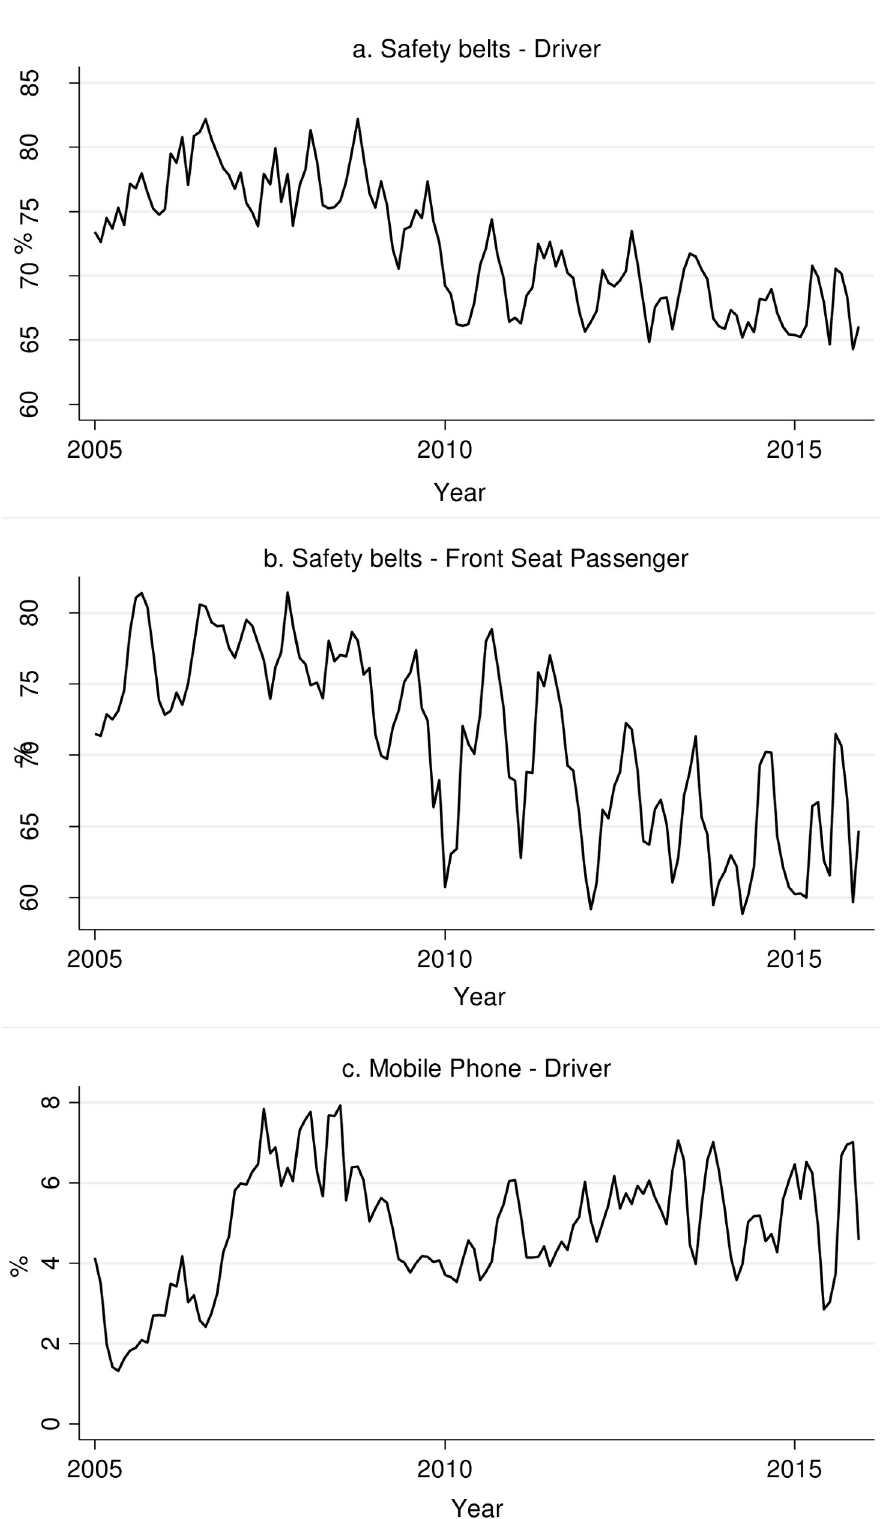
Fig 1. SB use by the driver ( 1a ) and the FSP ( 1b ) and MP ( 1c ) use by the driver from 2005 to 2015 (3-month moving average).